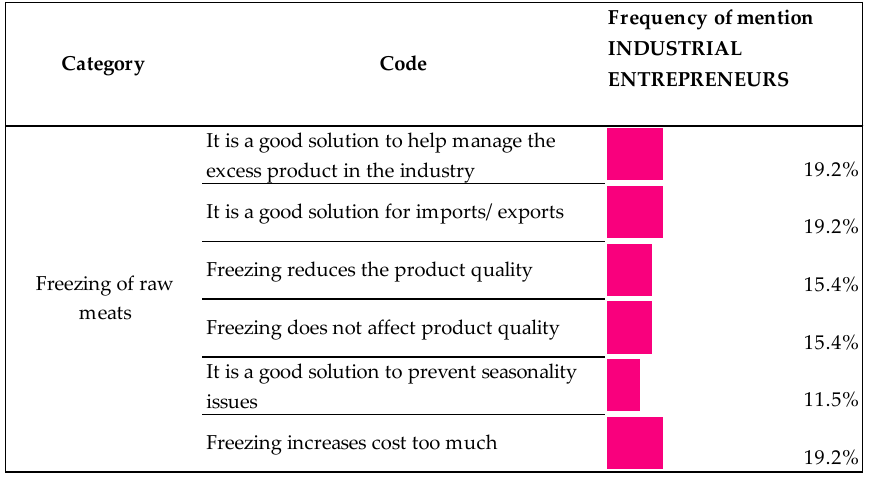
Figure 7. Industrial entrepreneur views on the requirements of the QS (Quality Standard) in terms of product freezing. (Scale: frequency of mention of each opinion. Percentage is based on responses in the given code out of all responses to equal 100%).